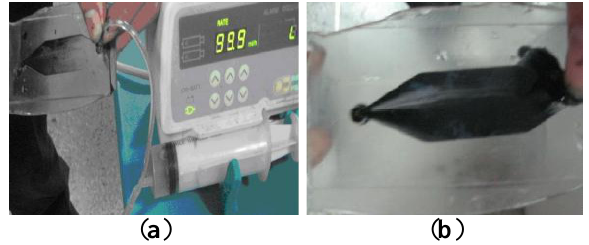
Figure 14. ( a ) The injection of black ink into the channel; ( b ) the result of the parabolic laminar hypothesis.